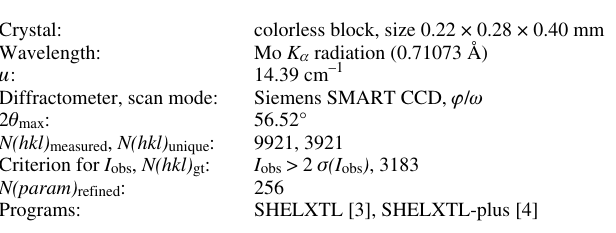
Table 1. Data collection and handling.